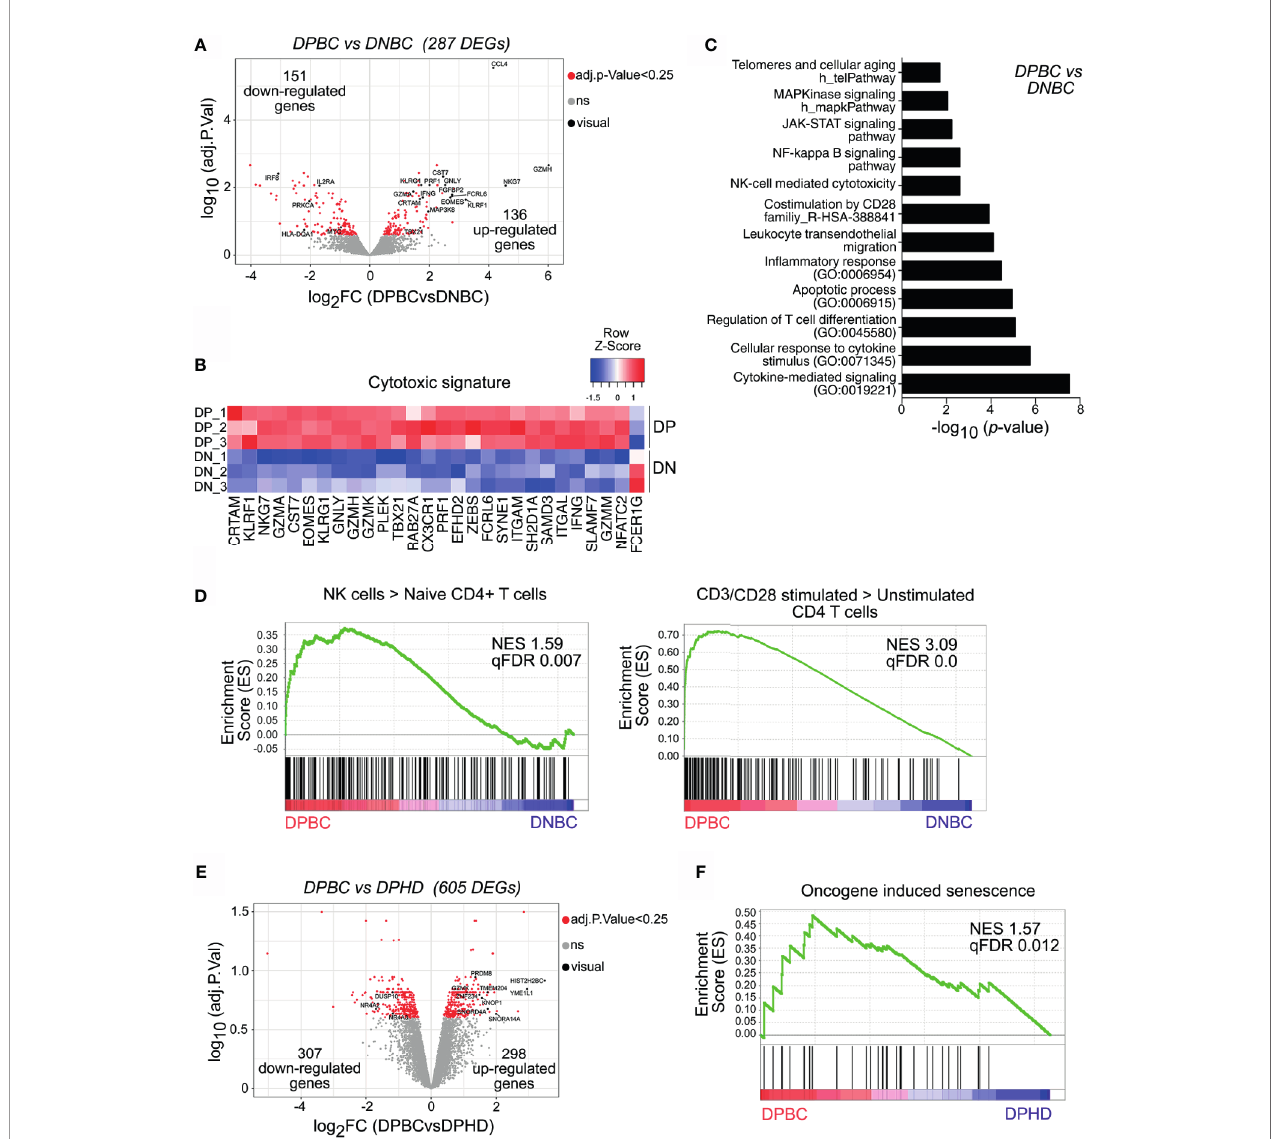
FIGURE 5 | CD4 + senescent T cells from breast cancer patients exhibit a distinctive transcriptional pro fi le. Affymetrix microarray analysis performed in sorted KLRG- 1 + CD57 + and KLRG-1 − CD57 − CD4 + T cells from BC patients (DPBC and DNBC, respectively) and KLRG-1 + CD57 + CD4 + T cells from HDs (DPHD). (A) Volcano plot shows differentially expressed genes (DEGs) between DPBC and DNBC samples ( p- value <0.05 corrected with Benjamini – Hochberg, indicated as red dots). Genes of interest are shown in black with their gene symbols. (B) Heat map shows the normalized gene expression of cytotoxic signature. (C) Graph shows the p-value of selected pathways signi fi cantly enriched in DEGs of panel A (DPBC vs DNBC) using EnrichR. (D) GSEA enrichment plots shows selected gene sets (GSE: 22886 and GSE: 45739) enriched in DPBC vs DNBC. Normalized enrichment score (NES) and p- value (FCRq) are indicated. (E) Volcano plot shows DEGs between DPBC and DPHD samples ( p- value < 0.05 corrected with Benjamini – Hochberg, indicated as red dots). Selected genes are highlighted in black. (F) GSEA plot shows the enrichment of the gene set Reactome oncogene-induced senescence in the transcriptome of DPBC vs DPHD. Signi fi cant p- value (FCRq) is